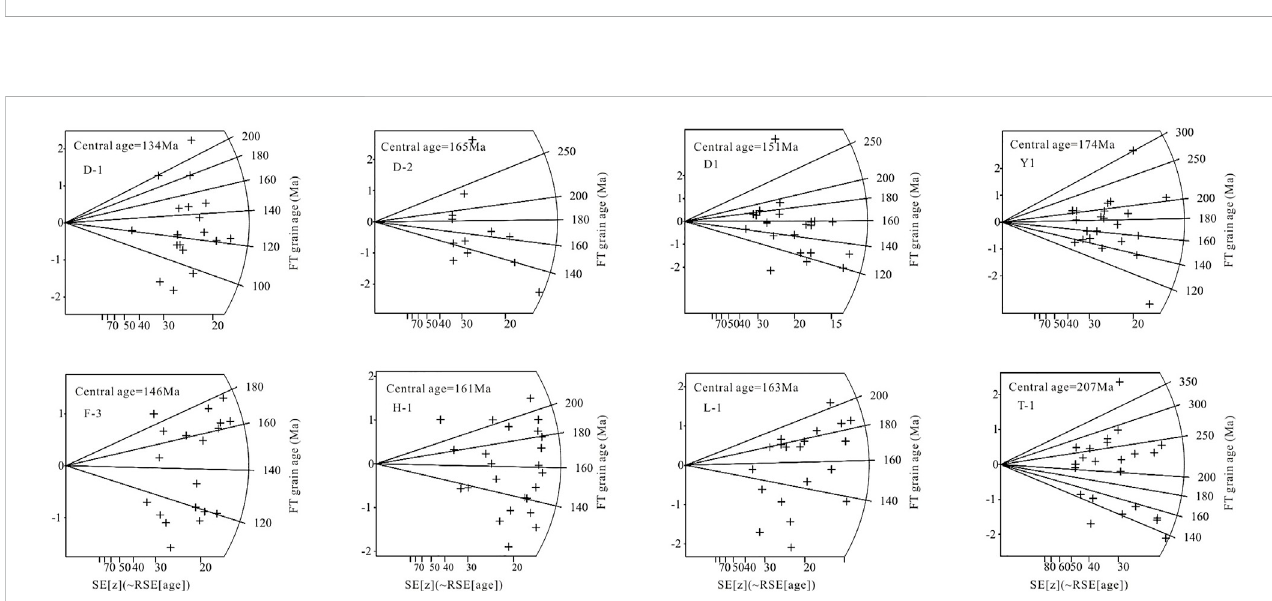
FIGURE 5 Radiograms of ZFT single grain ages from the northern Junggar Basin. X and Y -axes represent the age accuracy and standard deviations of single grains, respectively.